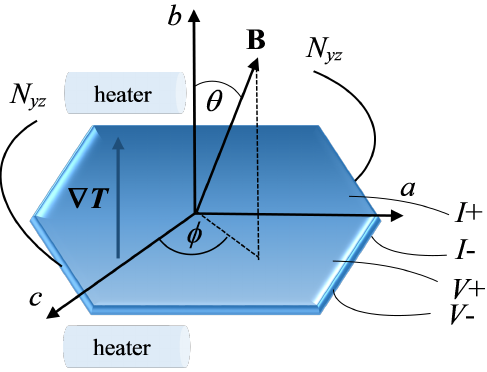
Figure 1. The experimental setup for the Nernst effect measurements as a function of the magnetic field strength and orientation. The temperature gradient ∇ T is along the less conducting axis, b -axis of the conductor, perpendicular to the Q2D conducting ac plane. The magnetic field B is rotated for angle θ from the b -axis to the ac -plane at a fixed azimuthal angle of φ = 37 ◦ from the c